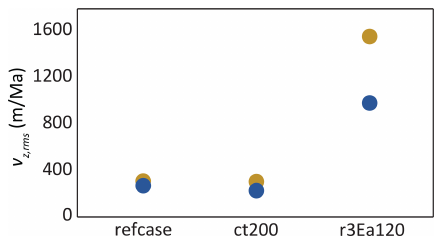
Figure B3. Diagram showing v z, rms for equivalent cases with (blue) and without (light brown) composition-dependent rheology. refcase corresponds to the reference case (see Fig. 3); ct200 corresponds to a case with τ c = 200Ma; and r3E120 corresponds to a case with η 0 = 2 . 87 × 10 18 Pas and E a = 120kJmol − 1 (i.e., the case with maximum melting in Fig. 6). All other parameters as in the reference case (Fig.